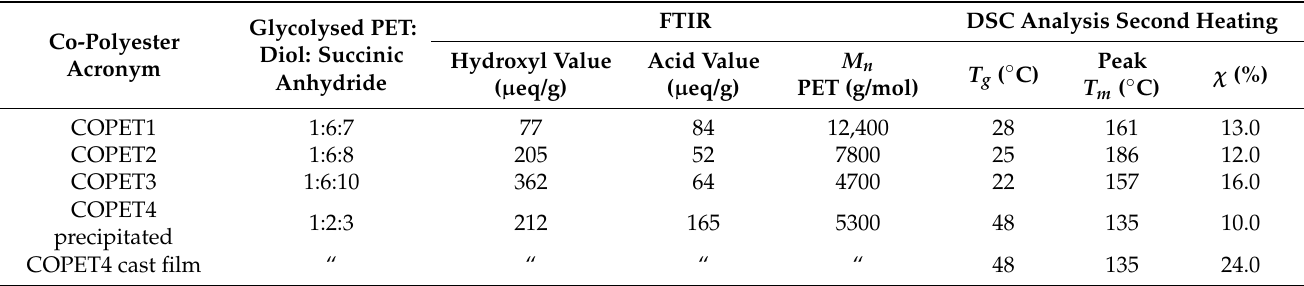
Table 2. Influence of SA and 1,3-PD content on co-polymer molar mass build-up and thermal